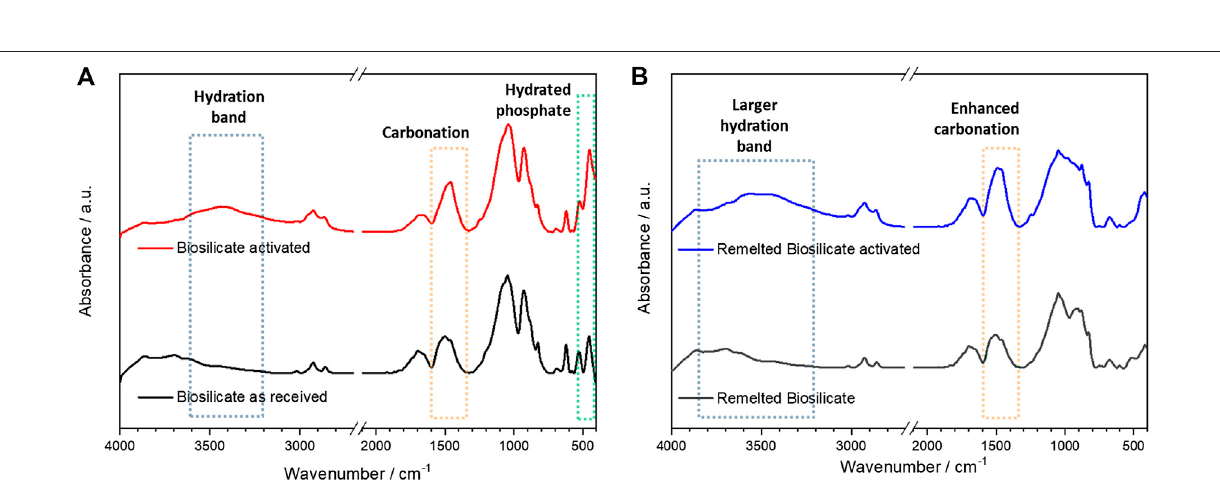
Frontiers in Materials |